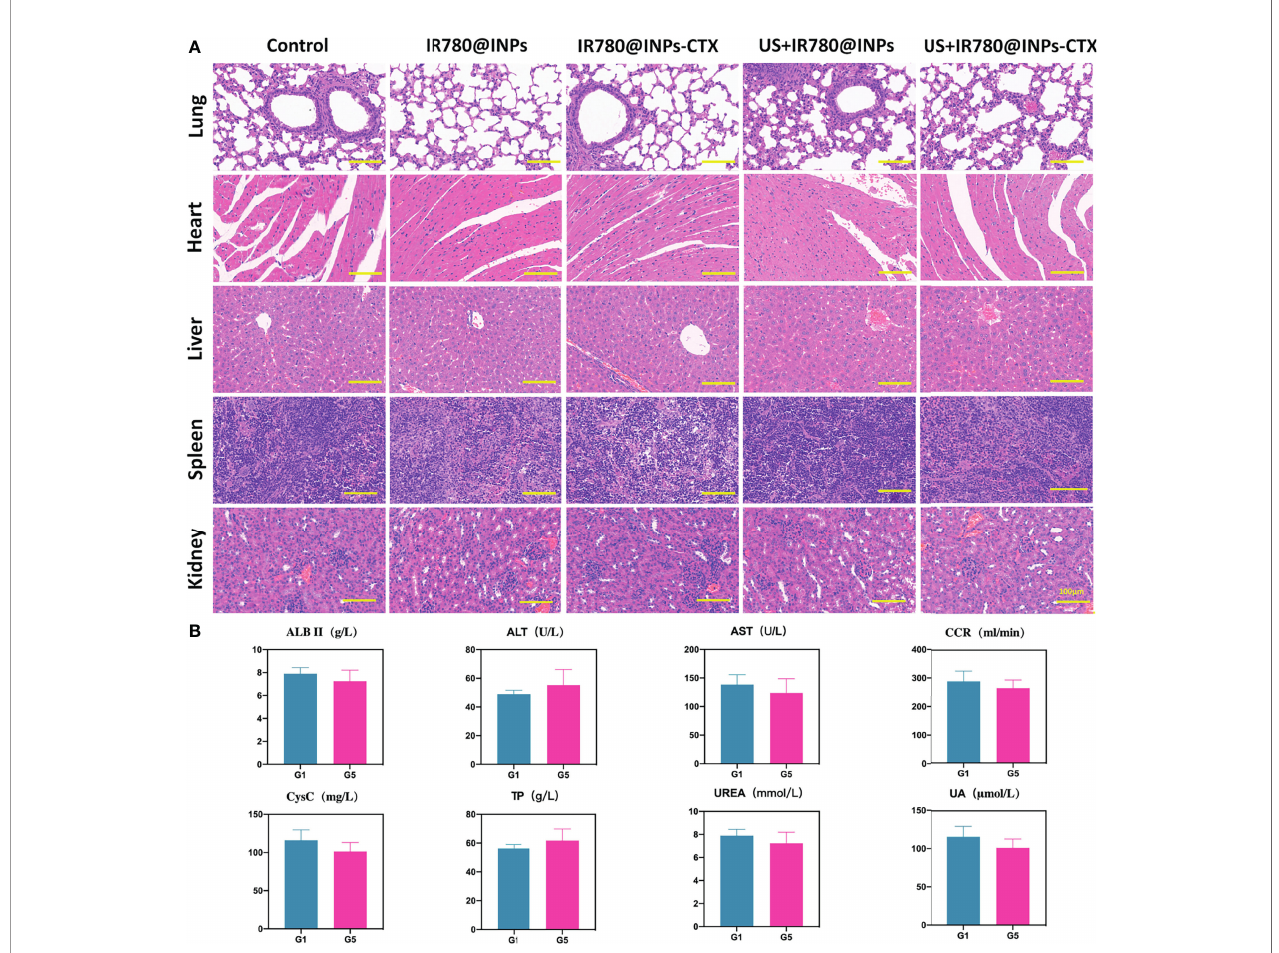
FIGURE 6 | In vivo toxicity evaluation of IR780@INPs-CTX. (A) H&E stained pictures of the main organs (lung, heart, liver, spleen and kidney) of mice, the scale bar is 100 m m. (B) Serological indicator examination of tumor-bearing mice in each group after treatment (G1: Control, G5: US+IR780@INPs-CTX), p<0.05 shows no signi fi cant difference between G1 and